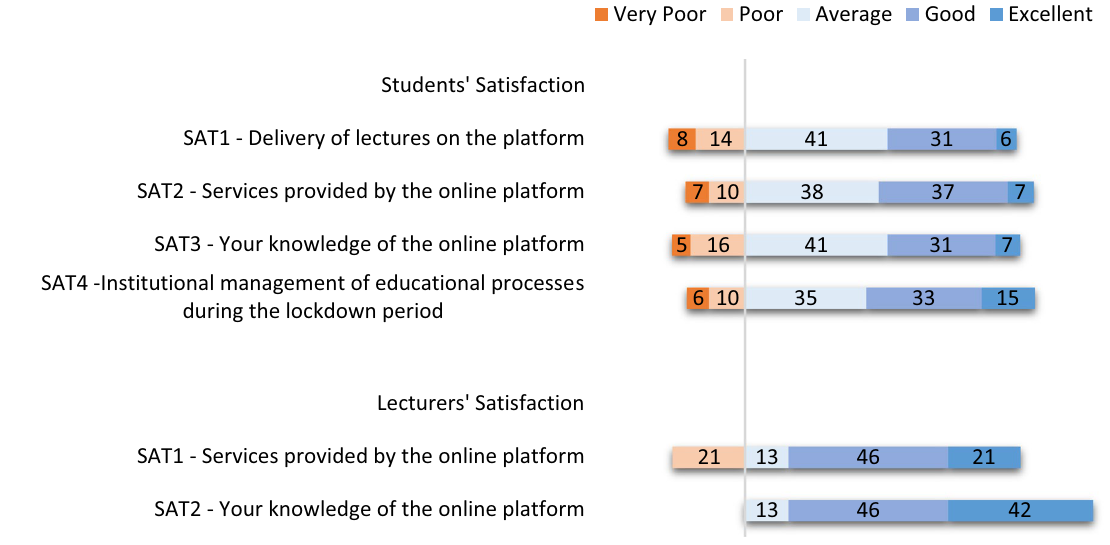
703) and teachers ( n 60) satisfaction (SAT) in percentage (%) from the five-point = =